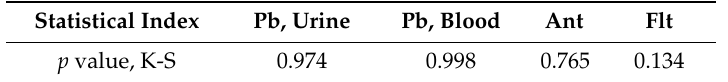
Table 10. Kolmogorov–Smirnov (K-S) test result. The test was applied to data referring to the air route only. The comparison is between the E and NE group. Pb = Lead, Ant = Anthracene, Flt = Fluoranthene.